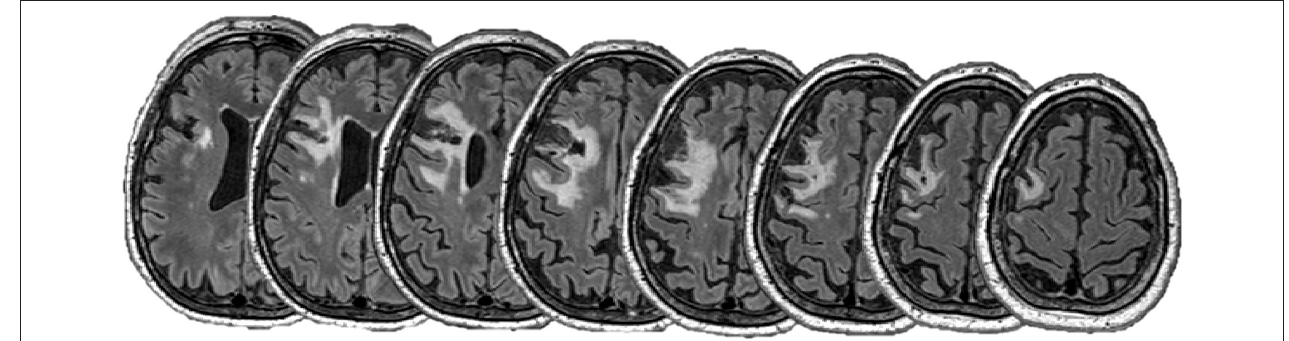
FIGURE 1 | FLAIR images showing the lesion. Images are spaced by 5mm.